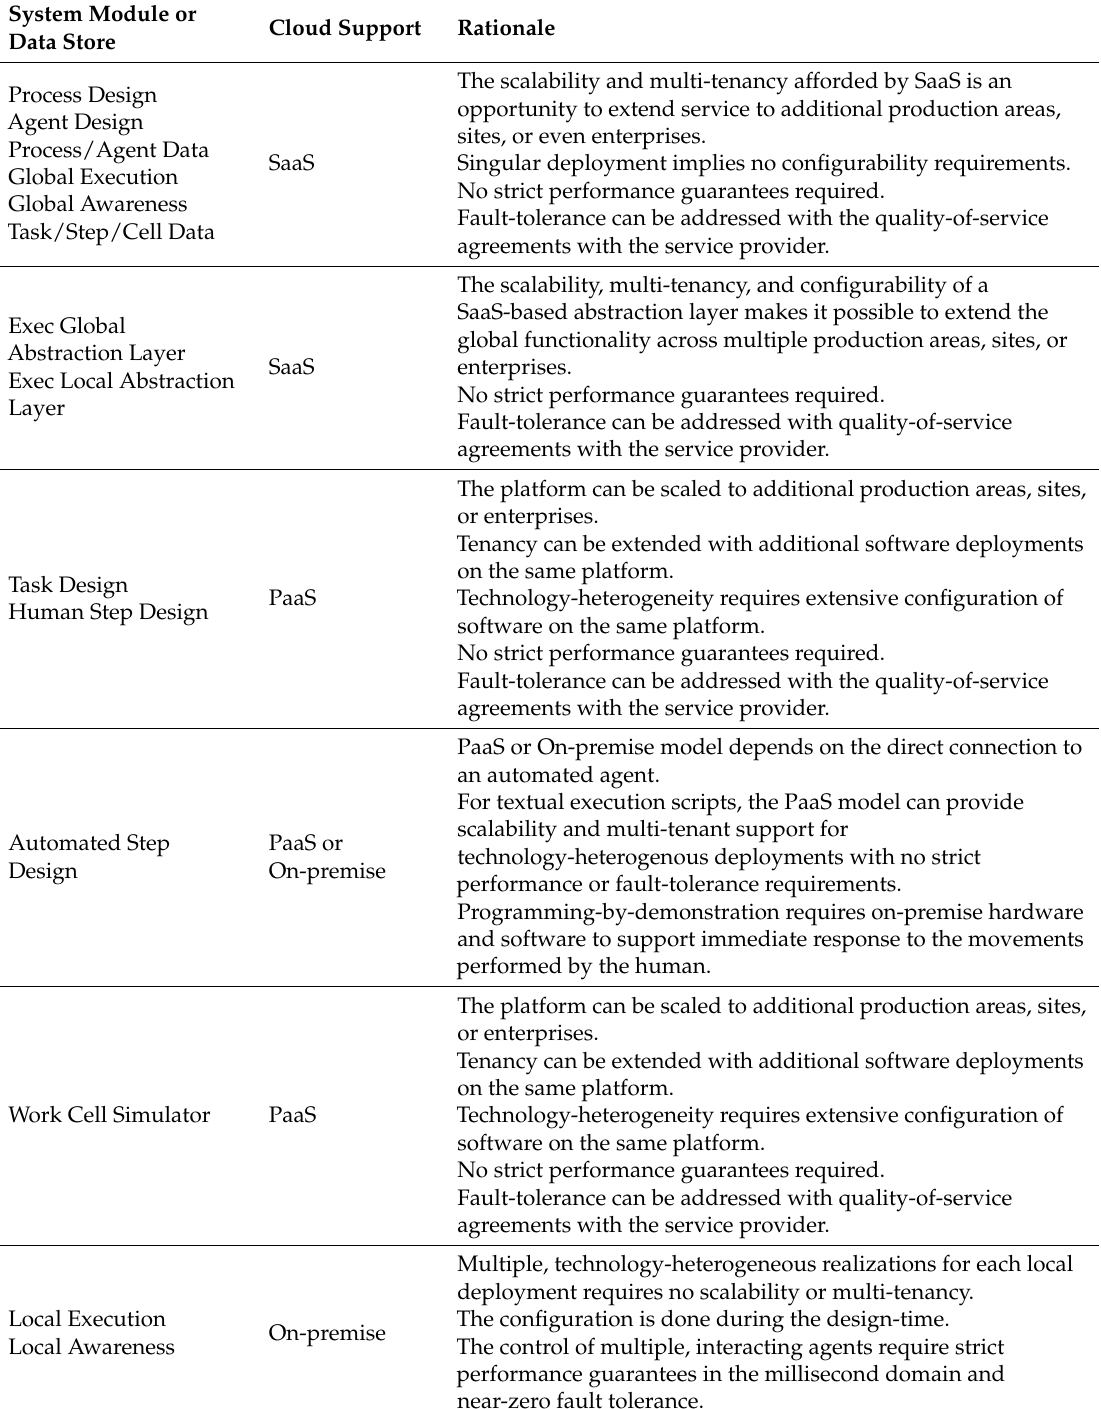
Table 2. Application of the five considerations for cloud-support for the modules of the HORSE System. System Module